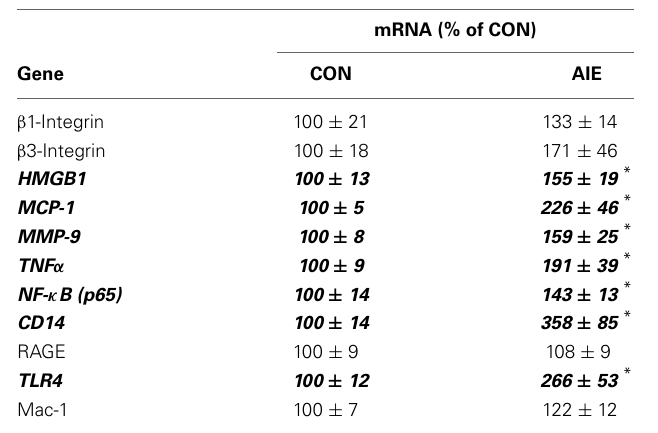
Table 2 | Adolescent intermittent ethanol (AIE) treatment increases mRNA expression of neuroimmune genes in the young adult hippocampus.